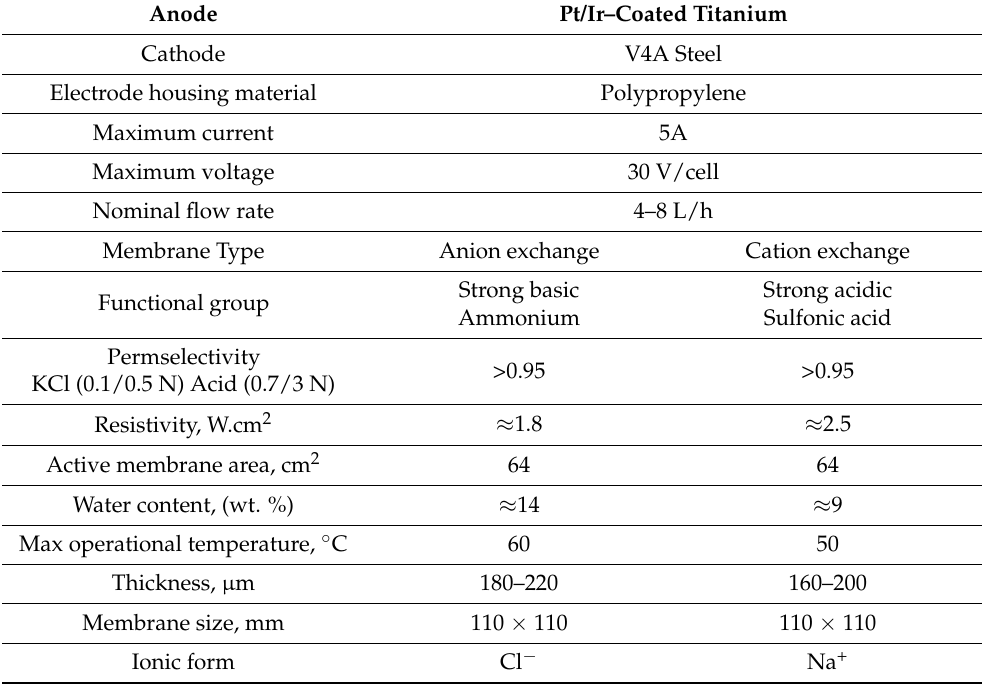
Table 2. Common properties of BPMED cell unit and ion exchange